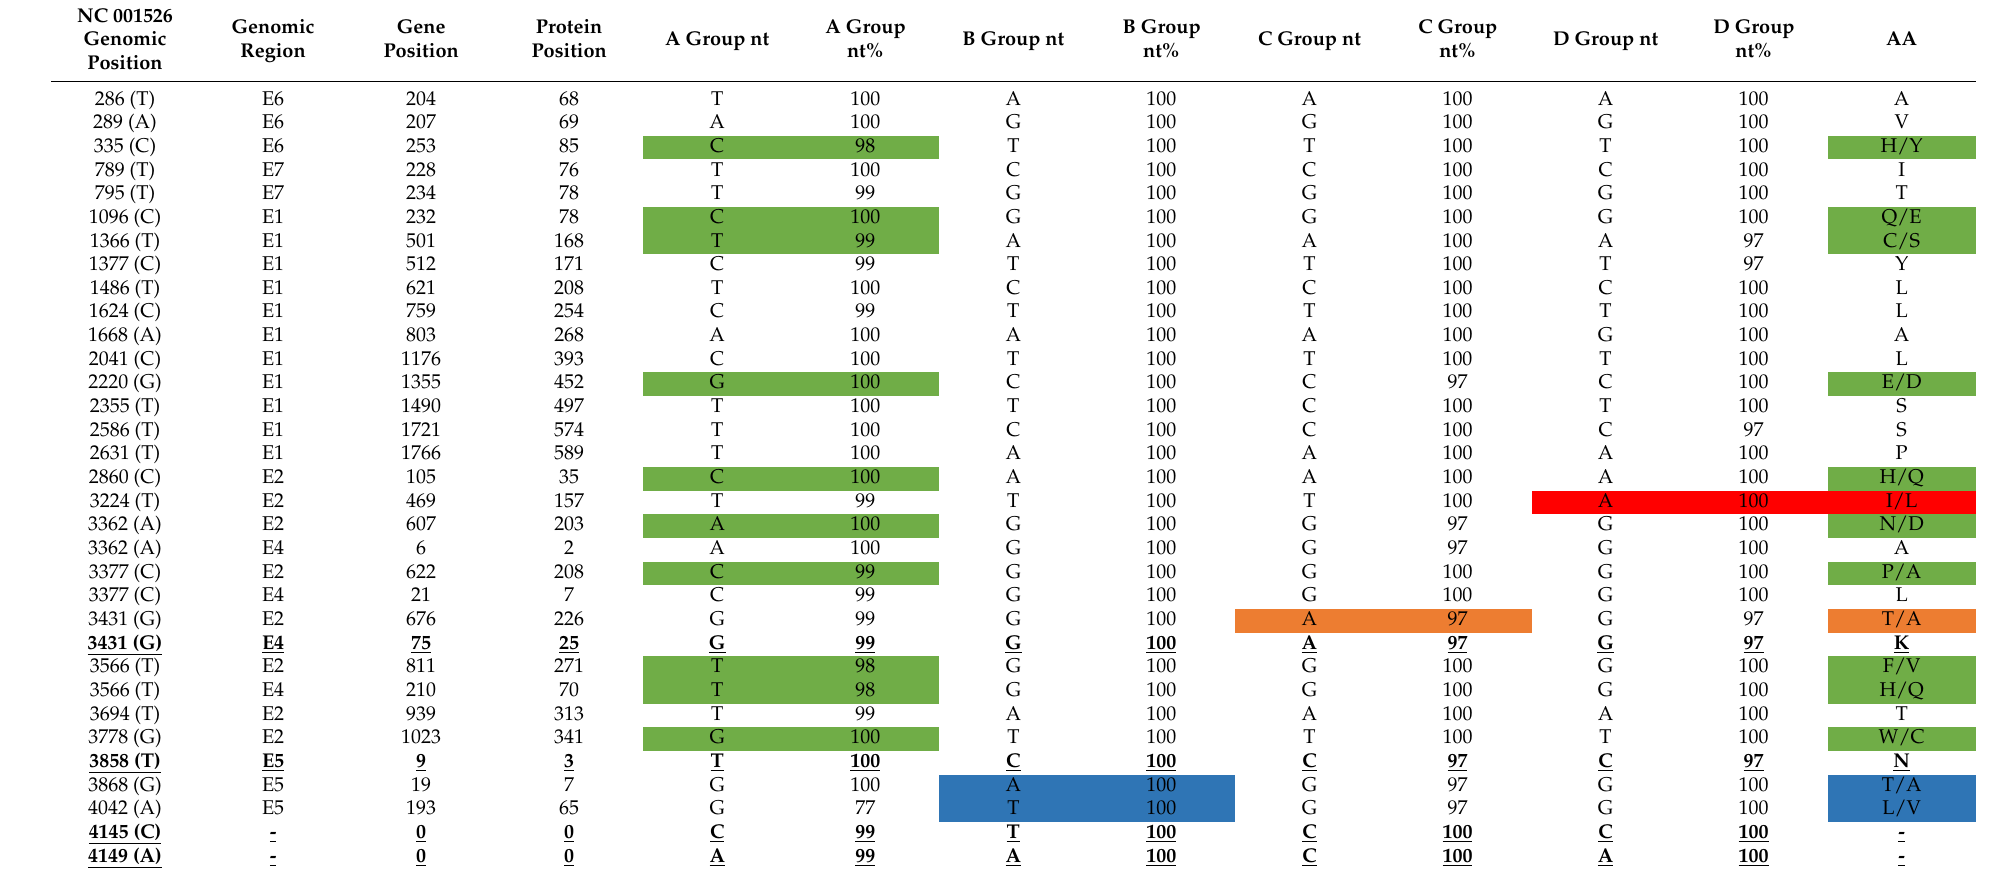
Table 1. Lineage-specific SNPs. The first column shows the genomic position of the specific SNP mapped to the A1 Reference genome NC_001526 and the corresponding reference nucleotide. The second column shows the genomic region which corresponds to this position. The third and fourth columns show the SNP position in the corresponding NC_001526 gene and protein sequences, respectively. The fifth to twelfth columns show the nucleotide of each group and the percentage it is found in the sequences. The last column shows the amino acid change effect of each mutation, with the first letter being the variant amino acid. Cell colour indicates the non-synonymous mutations and mutations that are not placed inside an ORF. Lineages A, B, C and D non-synonymous SNPs are denoted with green, blue, orange and red, respectively. Novel lineage-specific synonymous mutations identified in this study are shown in